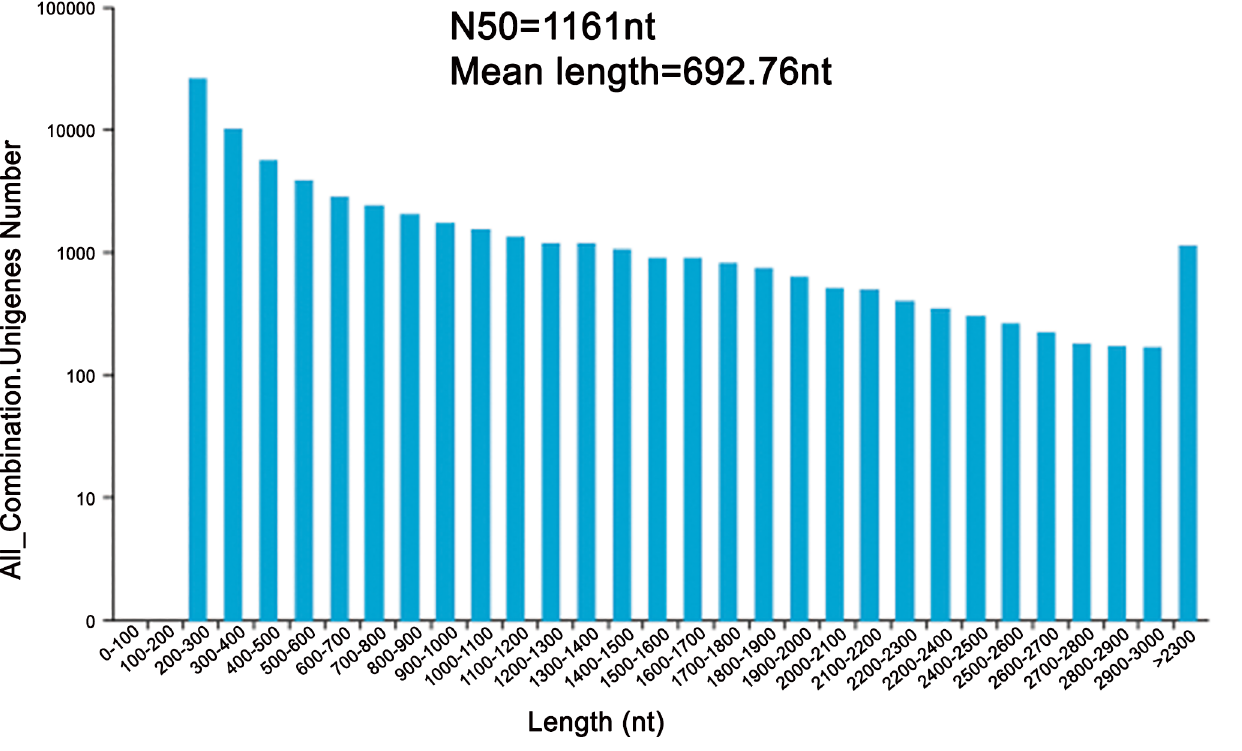
Fig 2. Histogram of length distribution of